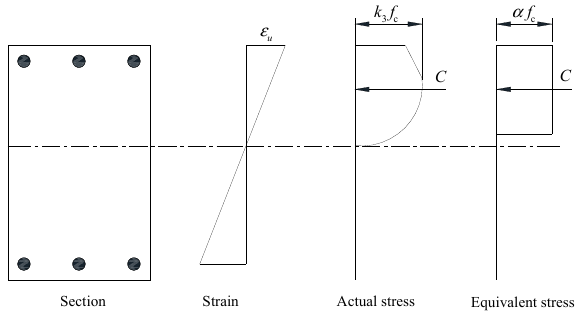
Figure 5. Concrete stress distribution and rectangular stress block.